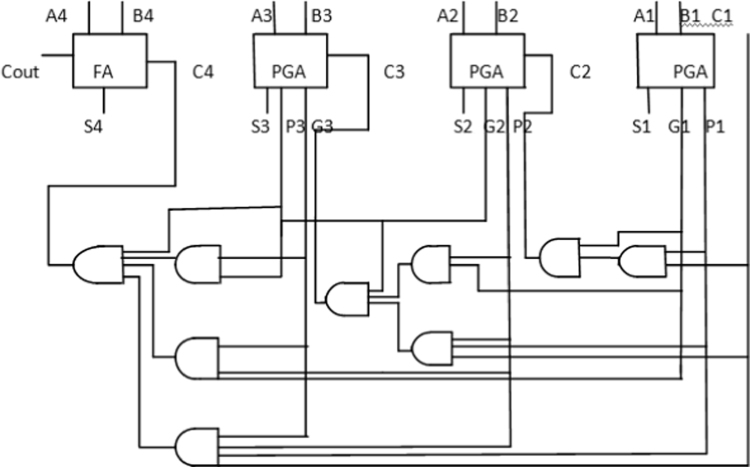
Conventional 4-Bit NCLA [5], [6].